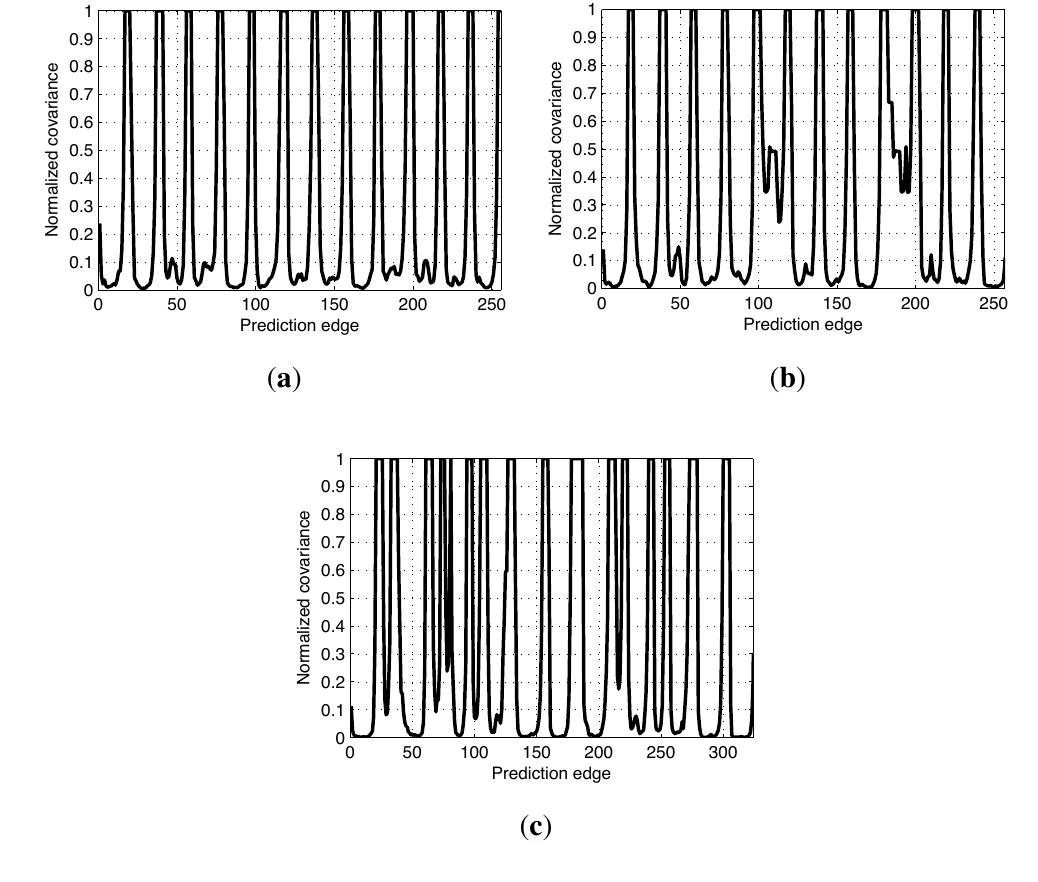
Figure 23. Normalized covariance values of the prediction edges. The nodes in each experiment were grouped based on the covariance values normalized by the maximum value. The nodes with uncertainty values less than 0 . 3 are grouped. ( a ) Experiment 1; ( b ) Experiment 2; ( c ) Experiment